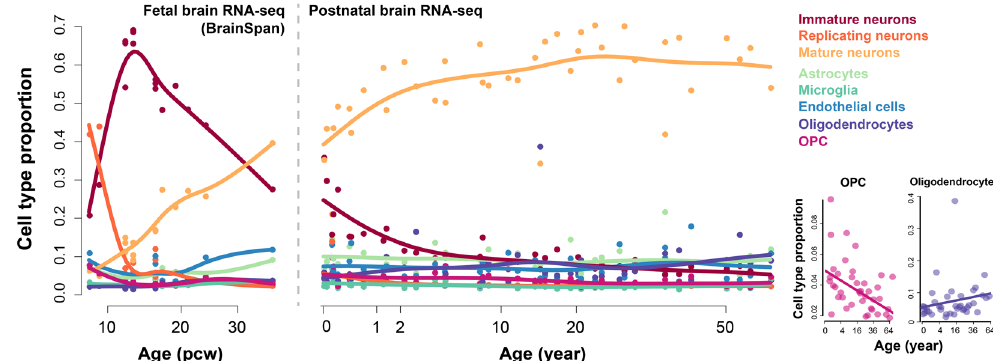
Figure 1. The cell type compositions across lifespan in human brains, estimated using the DR-based deconvolution. The dots show the estimated proportions of samples, and the curves show the spline interpolation results. The left panel shows the cell type composition in human fetal brains, based on the human embryonic developmental brain RNA-seq data from BrainSpan; the right panel shows the cell type composition in human postnatal brains, based on the human postnatal brain data set. The bottom-right panels show proportions of OPC and oligodendrocytes in the human postnatal